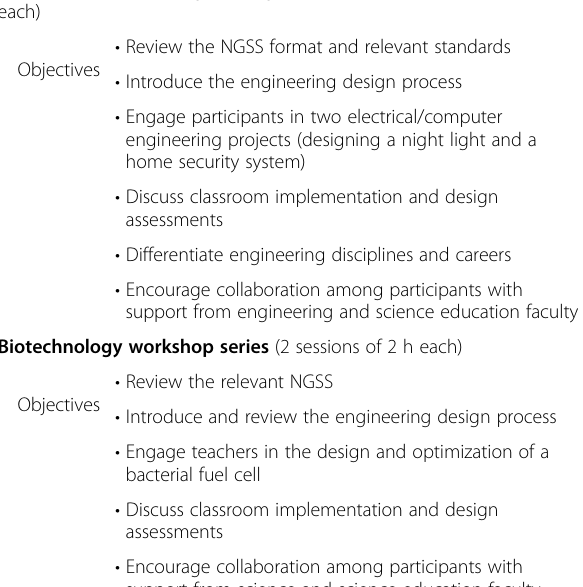
Table 2 Engineering professional development workshop